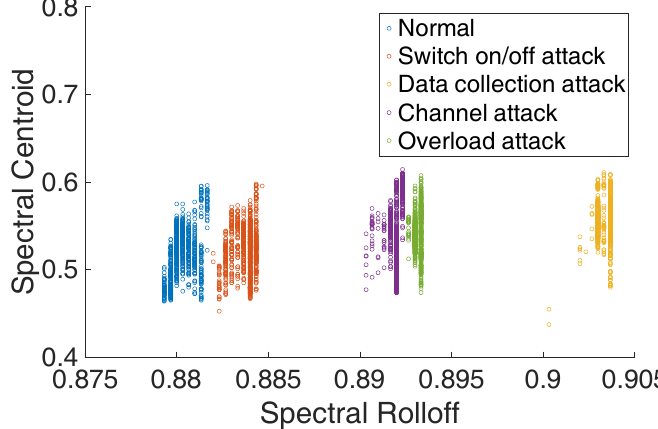
Figure 4. The feasibility to classify different attacks with different features. The features of each type of power signal cluster together separately, because the data collection attack runs in another OS version, its features are far away from